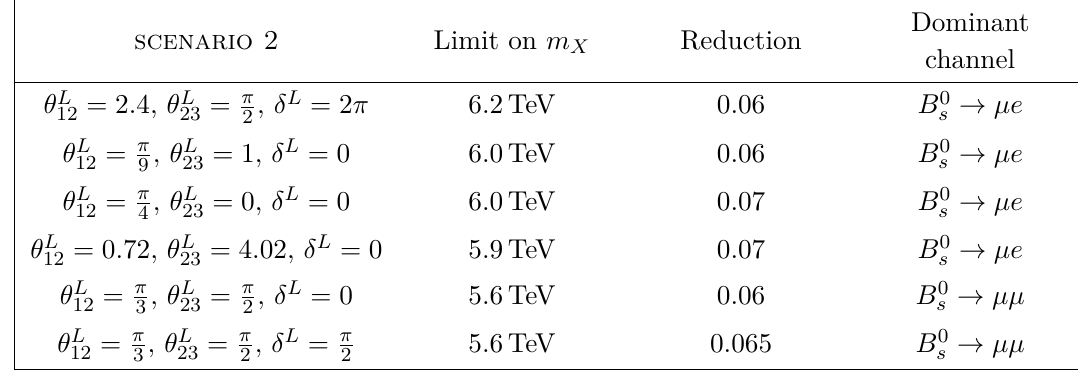
Table 9 . Limits obtained for the gauge leptoquark mass X µ for some different choices of mixing angles appearing in eq. (3.5) with an exact helicity suppression where we have chosen K de The decay process from which the dominant limit arises is also listed as well as the percentage reduction from the non helicity-suppressed scenarios in table 5. Each benchmark experiences a significant reduction in their mass limits of over an order of magnitude allowing for extremely light masses of X and significantly lower scales of PS µ